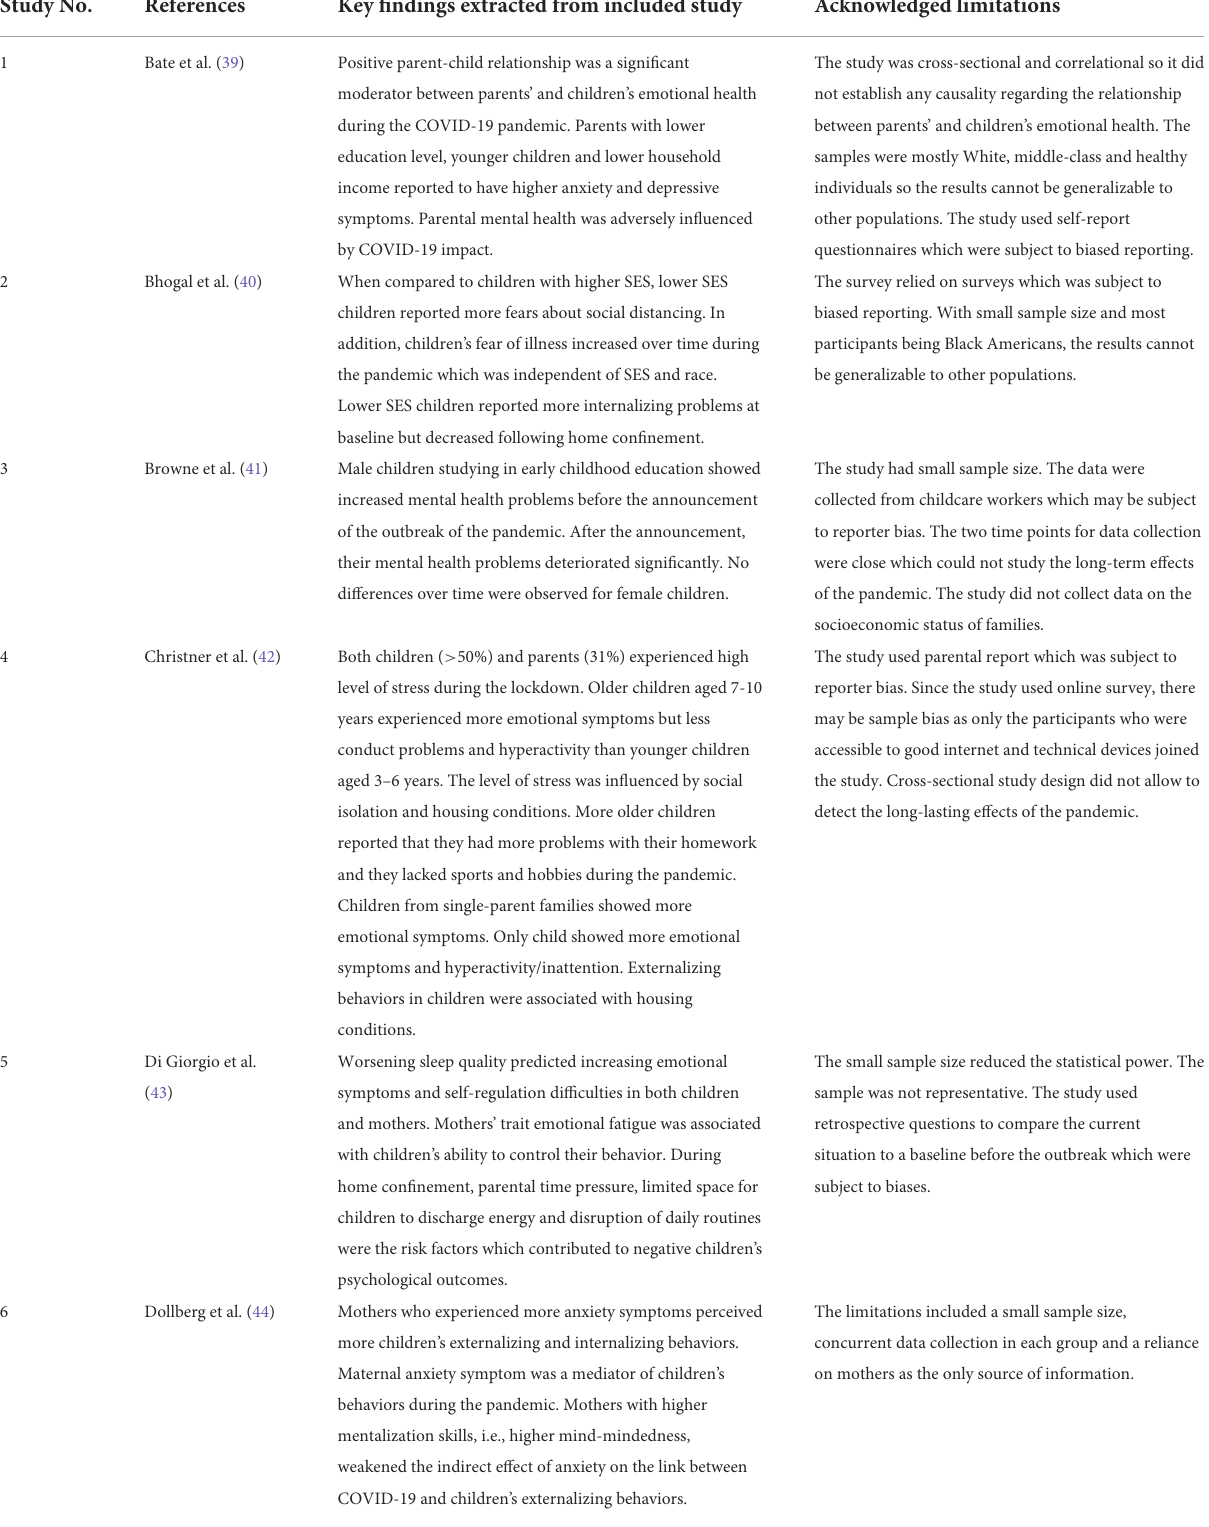
TABLE 2 The key findings and acknowledged limitations of included studies. Study